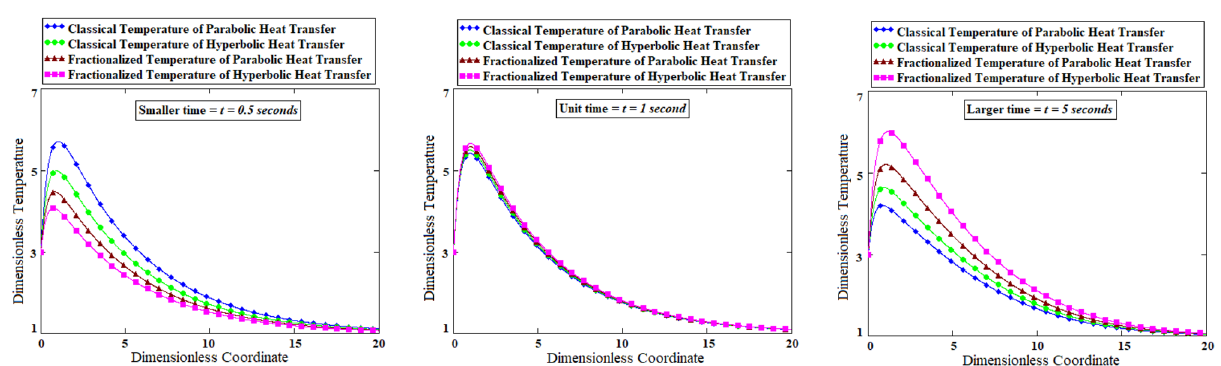
Figure 8. Comparative graphs of parabolic verses hyperbolic heat conduction for the classical and fractional approaches based on three different